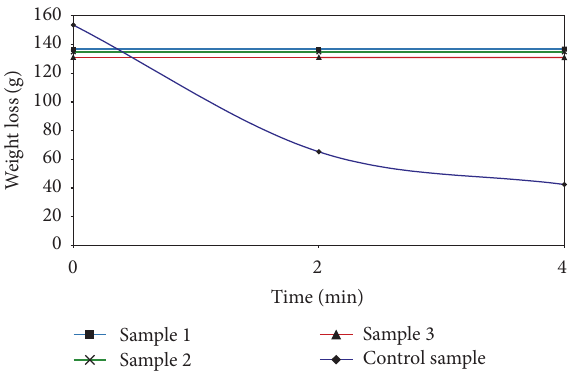
Figure 7: Weight loss versus time at 10m/s wind speed.